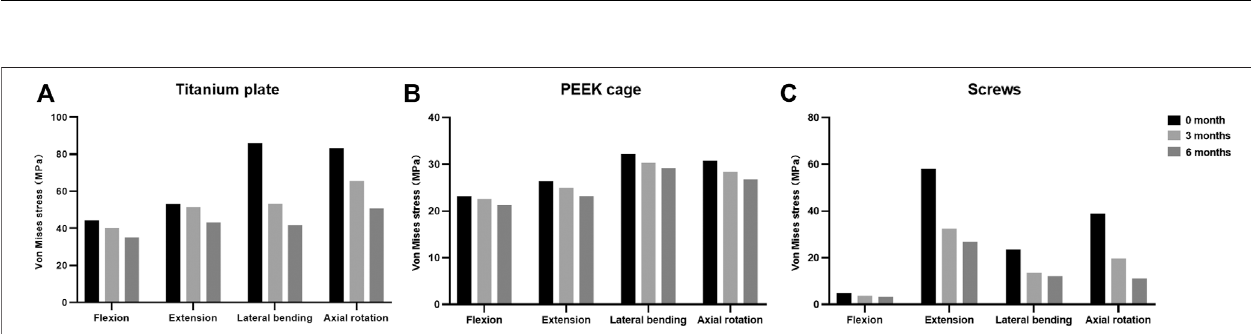
Frontiers in Bioengineering and Biotechnology |